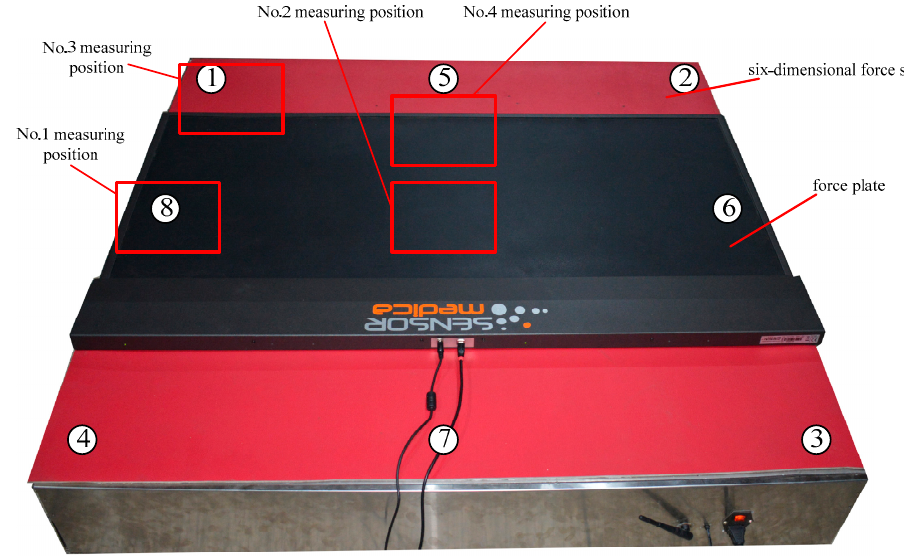
Figure 14. Measuring positions for the application experiments using a force plate and the proposed six-dimensional force sensor.